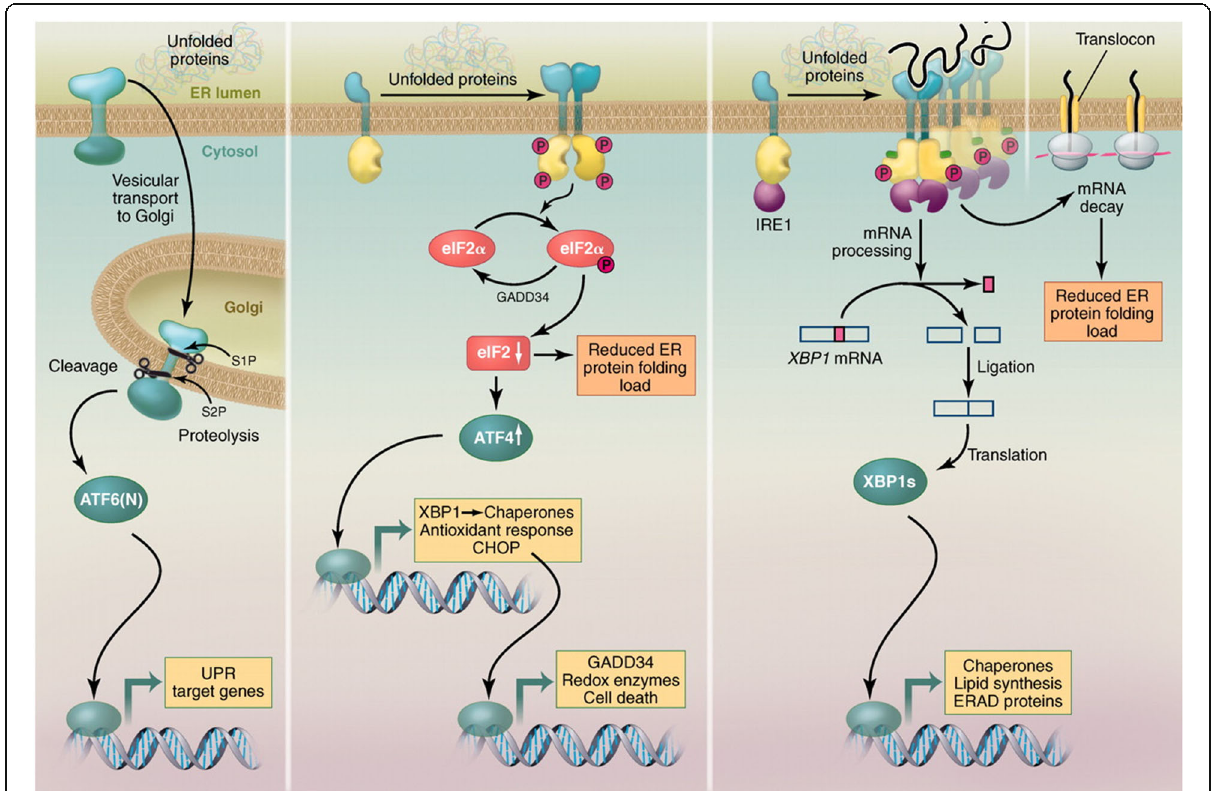
Fig. 1 ATF6, PERK, and IRE1 branches of a layered UPR signalling network. Layer 1 — unfolded proteins in the ER lumen. Layer 2 — ATF6, PERK, and IRE1 transmembrane ER sensors. Layer 3 — core processors. Layer 4 — ATF6(N), ATF4, and XBP1s transcription factors. Layer 5 — UPR genome. Layer 6 — cellular programmes regulating cell death, lipid synthesis, ERAD, production of chaperones, redox enzymes, and GADD34. ATF4 , Activated transcription factor 4; ATF6 , Activating transcription factor 6; ATF6(N) , Activated transcription factor 6 N-terminal cytosolic fragment; elF2 , Eukaryocyte initiation factor 2; ER , Endoplasmic reticulum, ERAD , Endoplasmic reticulum assisted degradation; GADD34 , Growth arrest and DNA damage-inducible protein; IRE1 , Inositol requiring enzyme 1; P , Phosphorylation; PERK , Double-stranded RNA-activated protein kinase-like ER kinase; S1P , Site-1 protease; S2P , Site-2 protease; UPR , Unfolded protein response; XBP1s , X-box binding protein1s with subscript s indicating nonconventional mRNA splicing transmits UPR signalling. Adapted with permission from Walter et al.